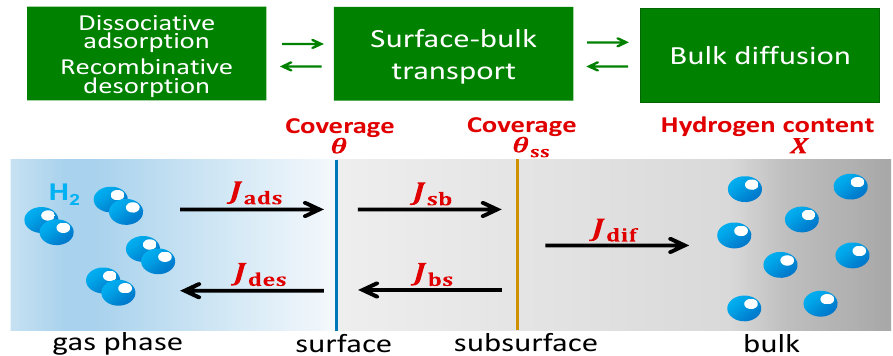
Figure 1. Conceptual schematic diagram of hydrogen absorption into metals. J abs and J des are the hydrogen fluxes for the surface adsorption and desorption processes, respectively; J sb and J bs are the fluxes for the migration of hydrogen from the surface to the subsurface, and from the subsurface to the surface, respectively; and J dif is the hydrogen flux for the diffusion in the bulk region.